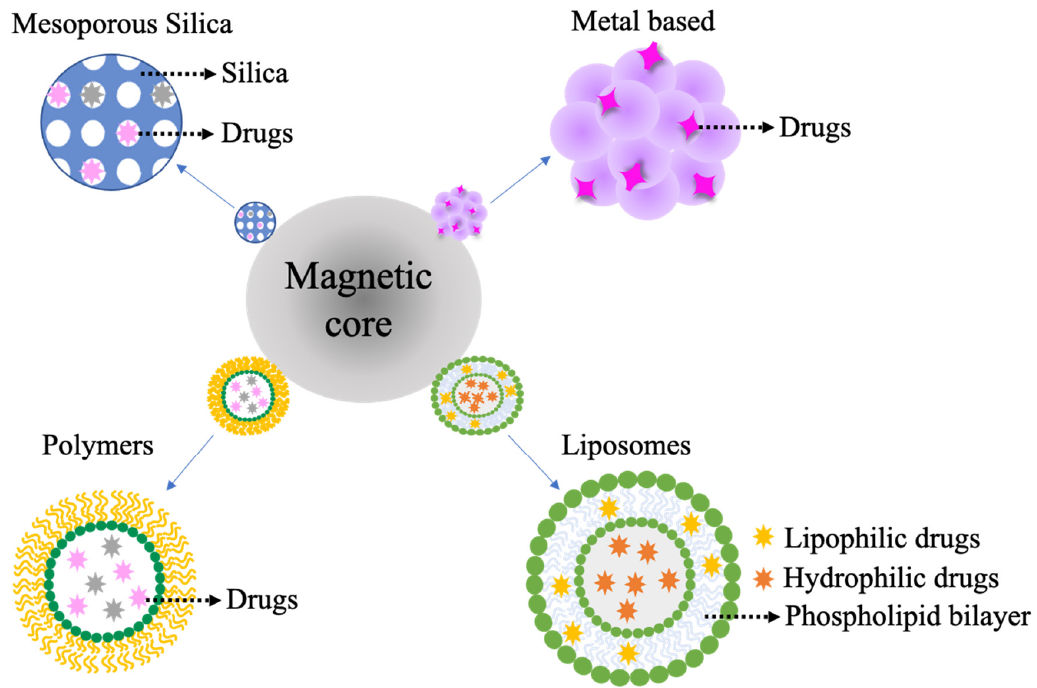
Figure 4. Types of nanomaterials that can be added to a magnetic nanoparticle core for more efficient and targeted drug delivery.